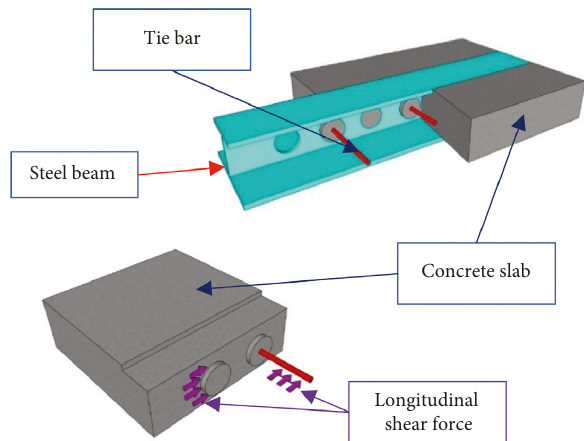
Figure 12: Longitudinal shear force transfer mechanism in con- crete dowel and